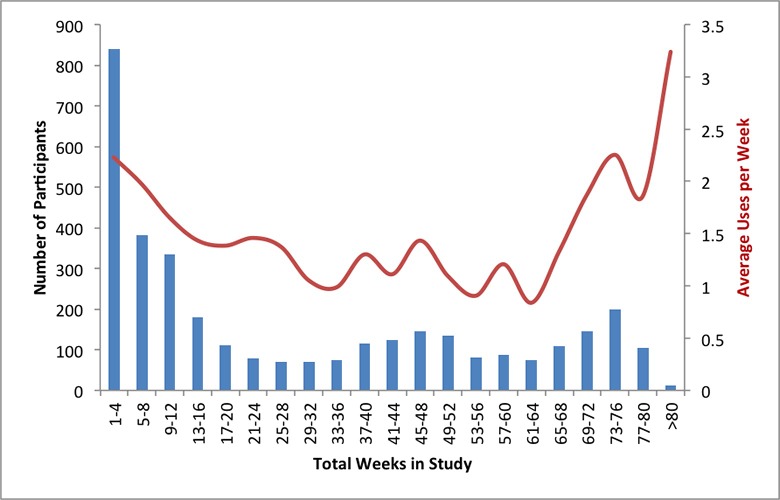
Amount of device usage by total time in study.X-axis indicates total time in study from device recording to last device recording. Y-axis on left indicates number of participants who remained in the study for the given total time intervals. Y-axis on the right average number of times device per week by the participants in each of the time intervals.